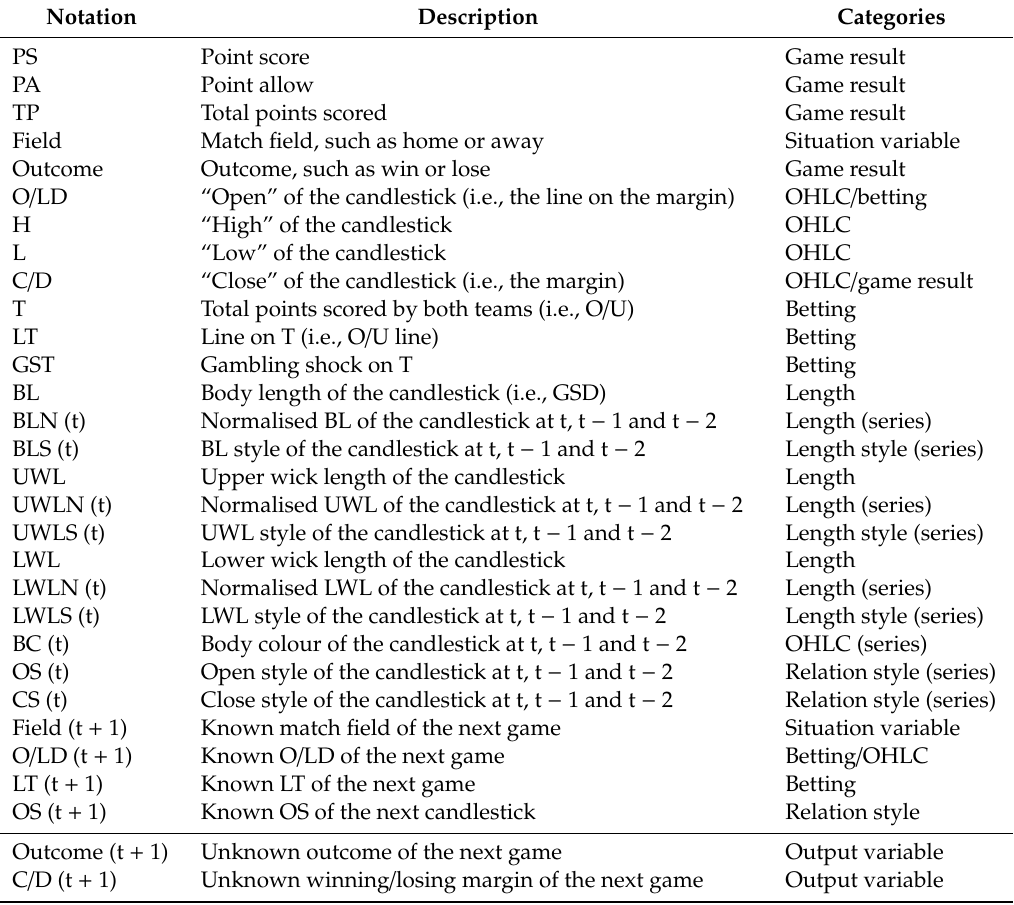
Table 1. Description of the features used in this